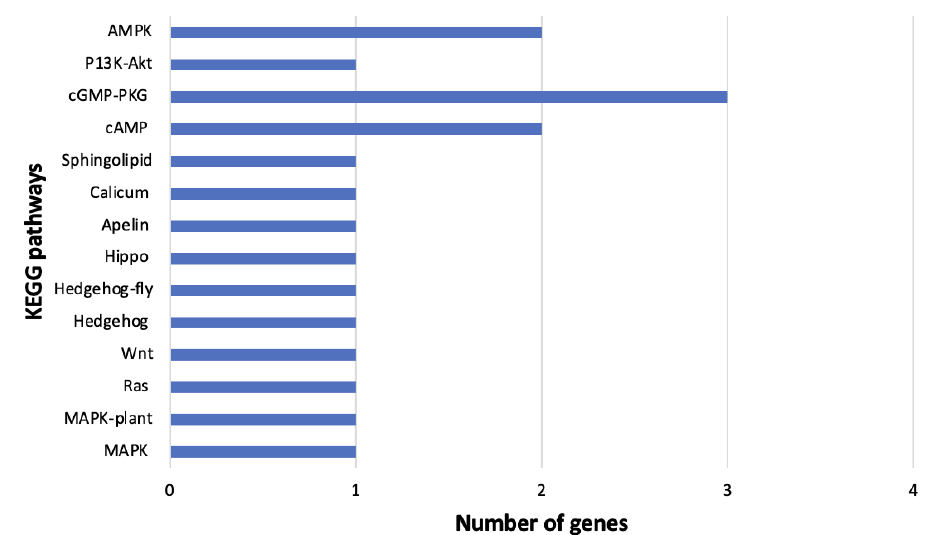
Figure 9. KEGG pathways pertaining to signal transduction identified in viruliferous Bemisia tabaci Mediterranean. The number of differentially expressed genes involved in each pathway are displayed on the x -axis.